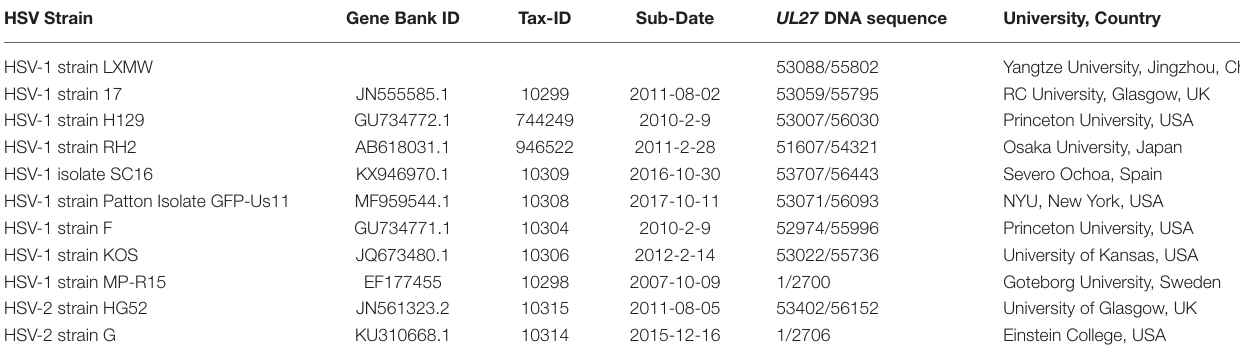
TABLE 1 | The information of HSV strains studied in this